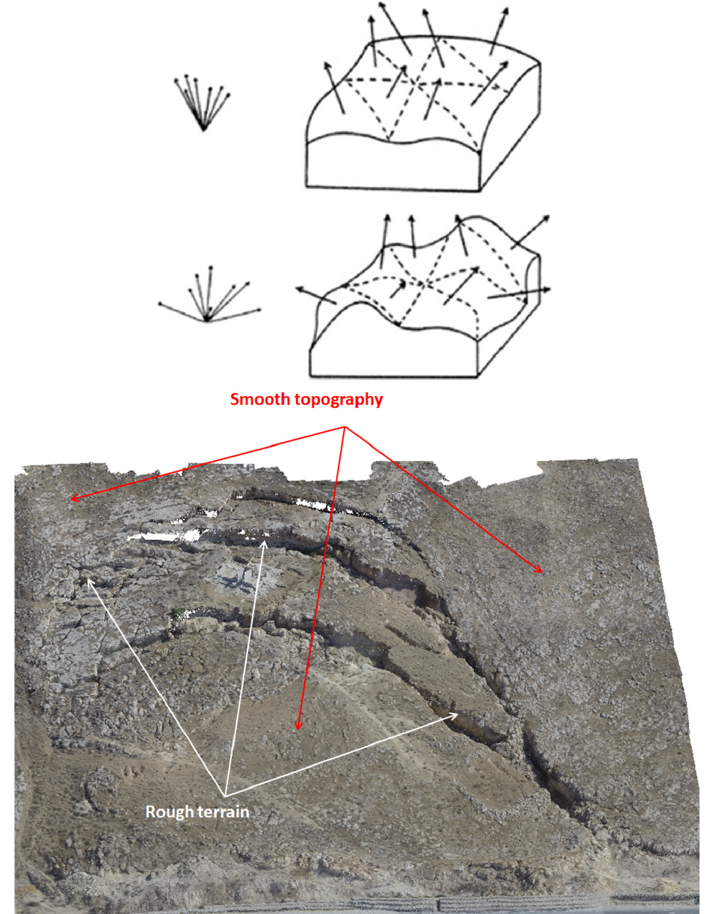
Figure 9. Surface normal representation of topographic surface roughness in a digital elevation model (DEM). The difference between smooth terrain (top) and rough terrain (bottom), illustrates greater variability in the latter [12,101].